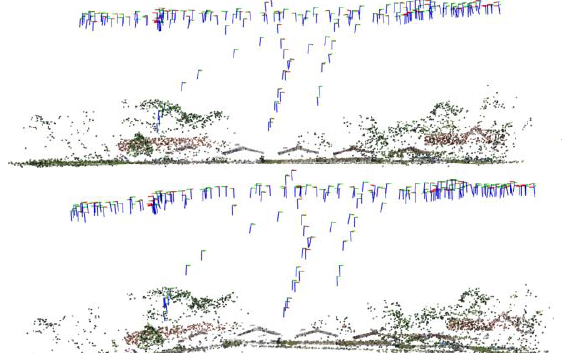
Figure 6. Top: Result for a UAV flight over a farm (185 images) computed with intermediate camera calibration. Bottom: Result with camera calibration activated only during the final adjustment. An area with weak point connectivity causes a part of the reconstruction to drift off.